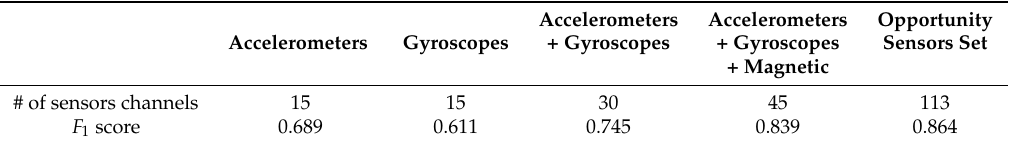
Table 10. Performance using different sensor